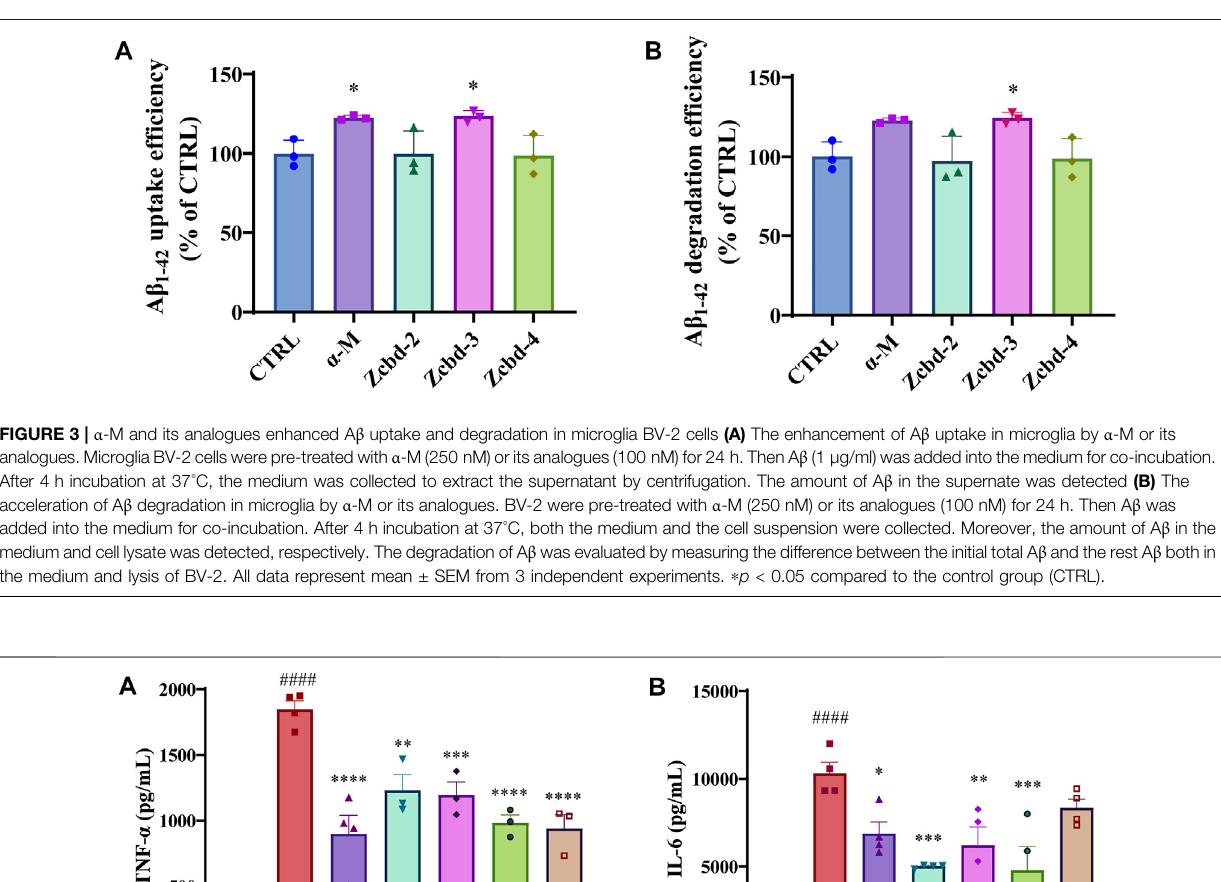
Frontiers in Chemistry |